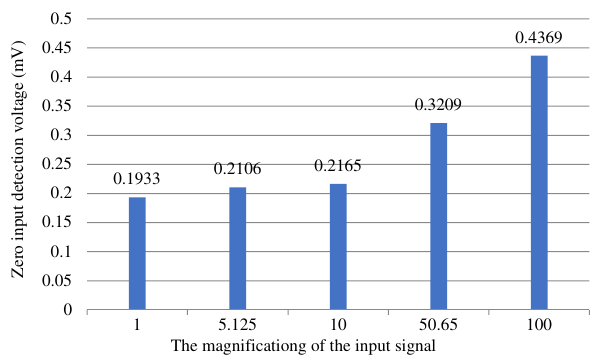
Figure 13. Zero-input response to the acquisition card.